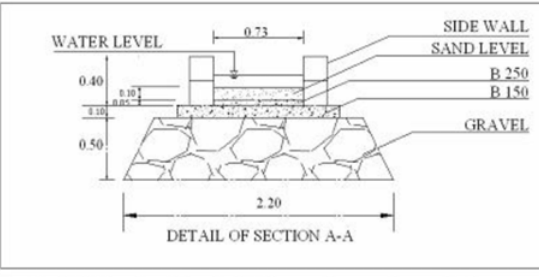
Fig. 2. Details of section A-A.